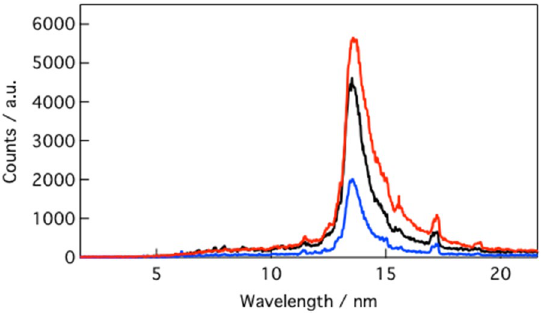
Figure 4. EUV emission spectra of bulk tin (black), 6-layer SnO 2 microcapsule (red) and 3-layer SnO 2 microcapsule (blue) ablated using a 7.1 × 10 10 W/cm 2 1 ns pulse.